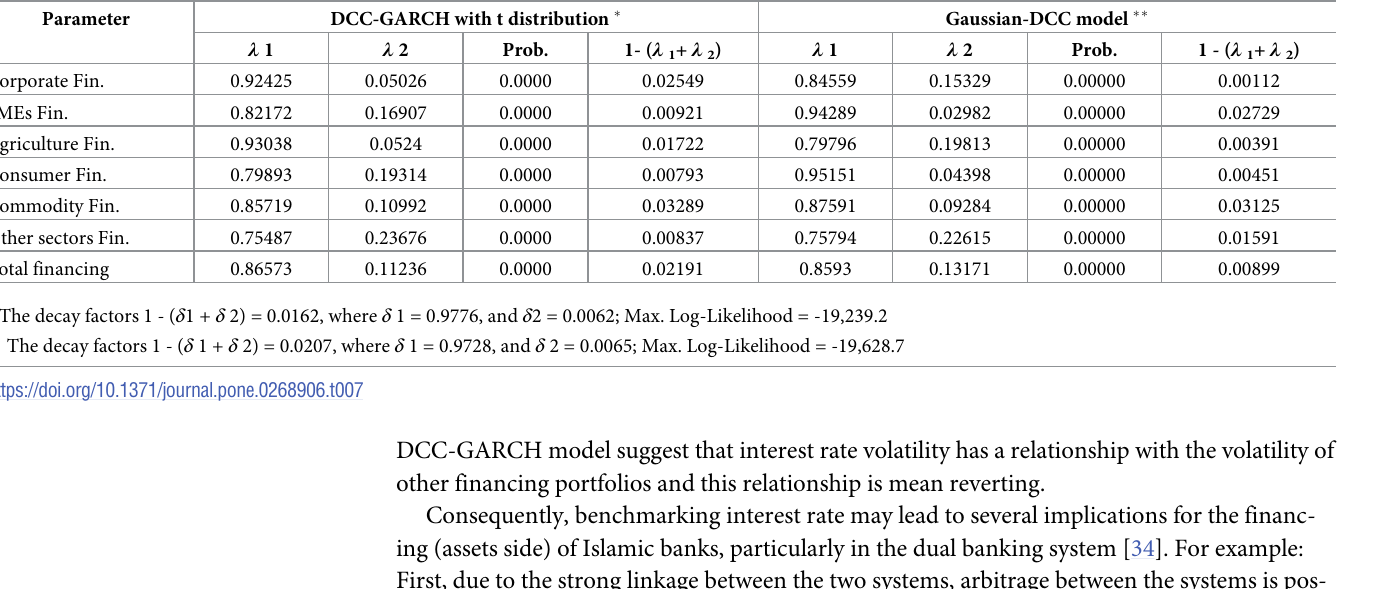
Table 7. Maximum likelihood estimates of DCC-GARCH models.